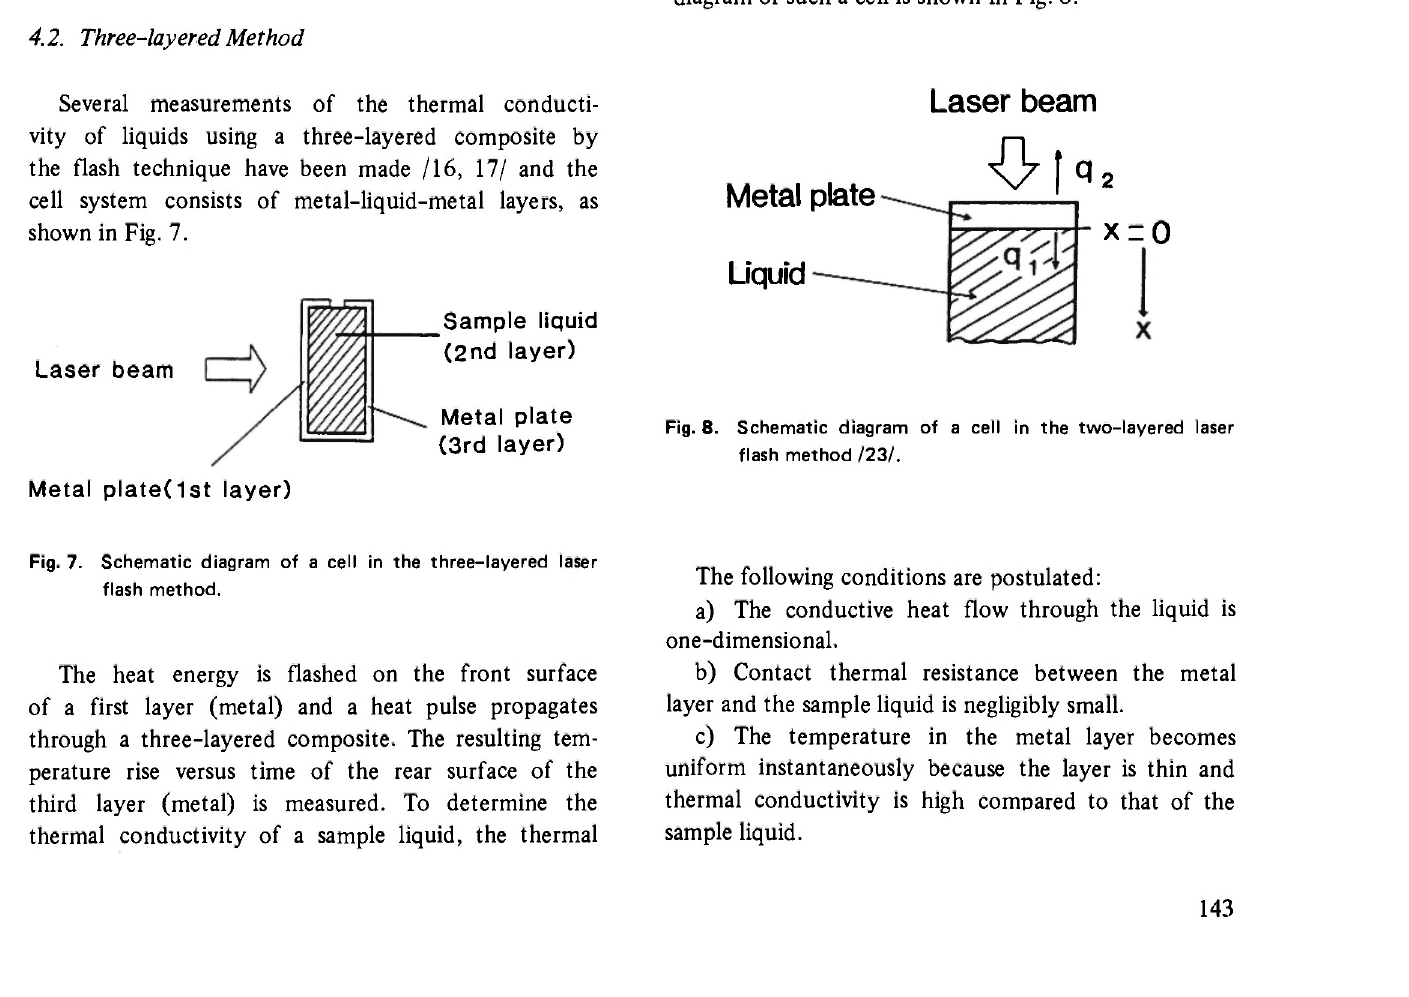
Fig. 7. Schematic diagram of a cell in the three-layered laser flash